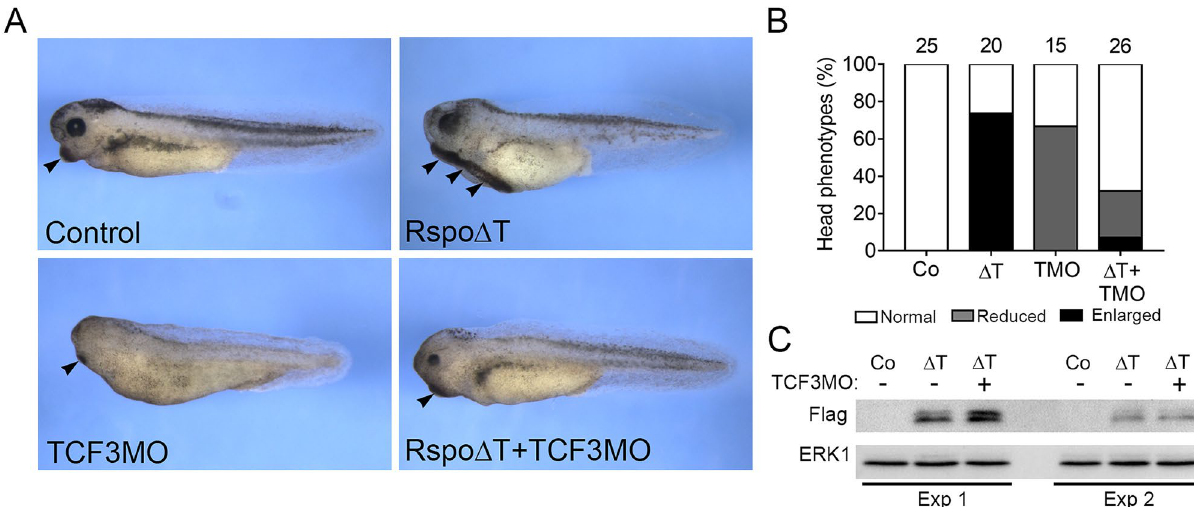
Figure 5. TCF3 is essential for Rspo2 inhibitory effects. ( A ) TCF3MO rescues the anteriorized phenotype of Rspo∆T RNA overexpressing embryos. Four-cell stage embryos were dorsally injected with TCF3MO (30 ng) and/or Rspo∆T RNA (0.5 ng). Arrowheads indicate the cement gland. ( B ) Quantification of the data in ( A ) representative of two independent experiments. Numbers of embryos per group are shown above each bar.